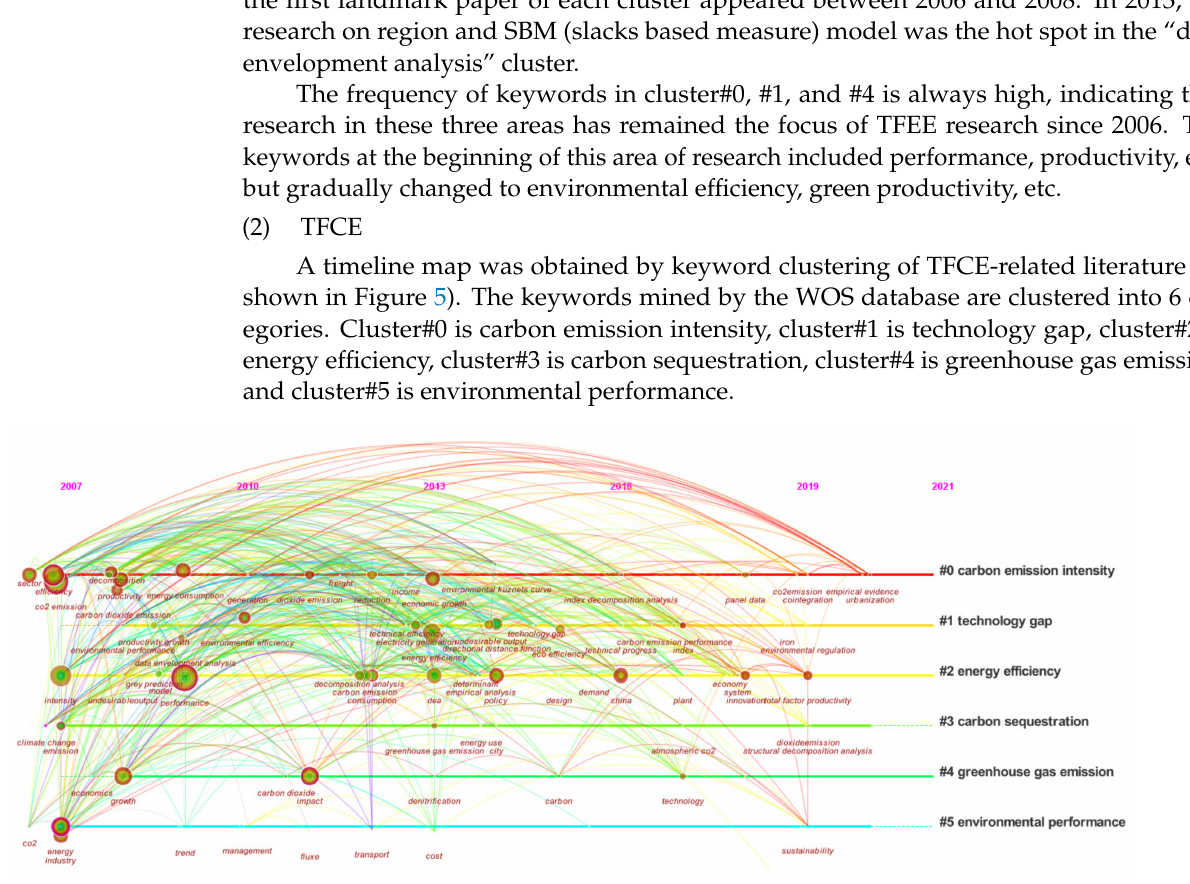
Figure 5. Timeline map of TFCE keyword